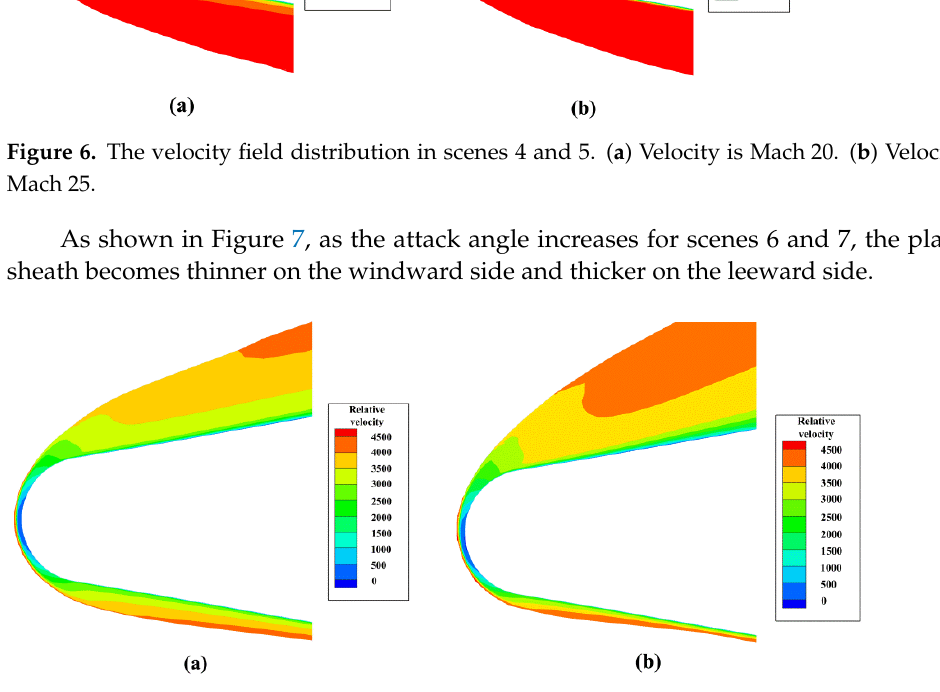
Figure 7. The velocity field distribution in scenes 6 and 7. ( a ) Attack angle is 10°. ( b ) Attack angle is 20°.